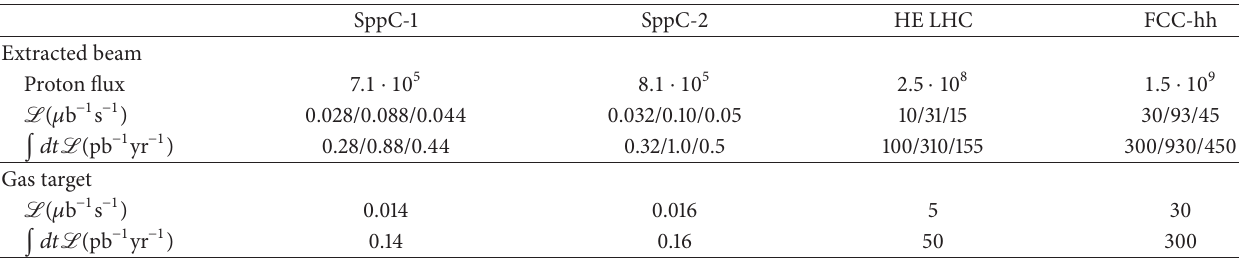
Table 2: Luminosities reachable in the fixed target mode. The proton flux is calculated by assuming that 5% of the beam is used per fill of 10 hours. The luminosities are calculated for the case of targets that are 1cm thick. The three values displayed represent luminosities for three different targets: liquid hydrogen, beryllium, and tungsten. The gas-target values are calculated using the same parameters as in [19] for a perfect gas at a pressure of 10 −9 Bar in a zone of 100cm.